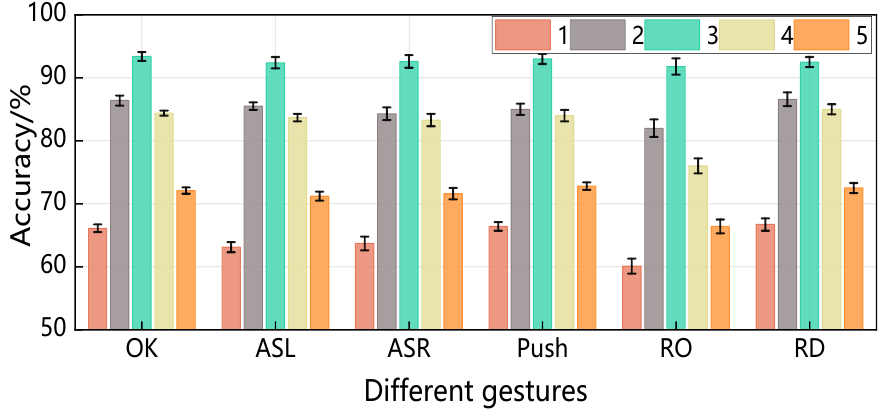
Figure 15. The effect of position on gesture accuracy.